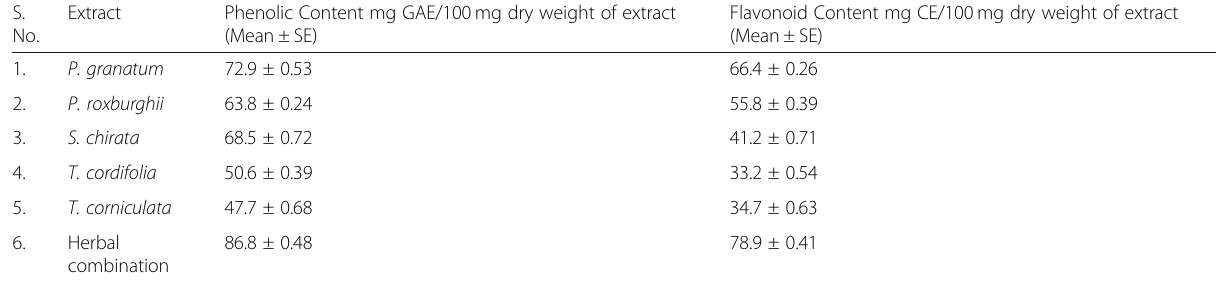
Table 3 Phenolic and flavonoid content in different plant extracts and herbal combination S.